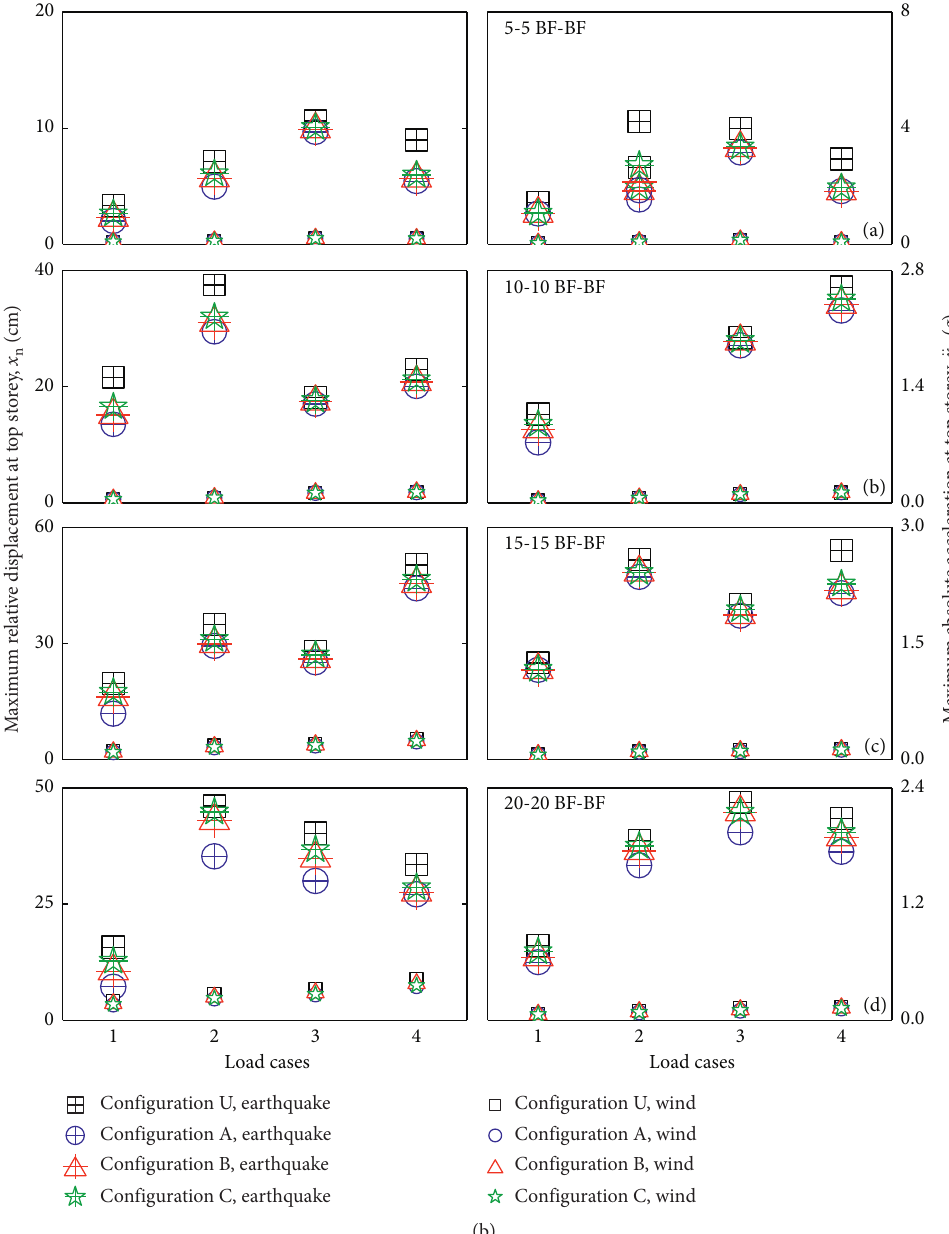
Figure 8: (a)Peak top floor displacement and acceleration responses of similar connected MRF-MRF buildings for equal storey height under historical earthquake ground motions and simulated wind forces. (b) Peak top floor displacement and acceleration responses of similar connected BF-BF buildings for equal storey height under historical earthquake ground motions and simulated wind